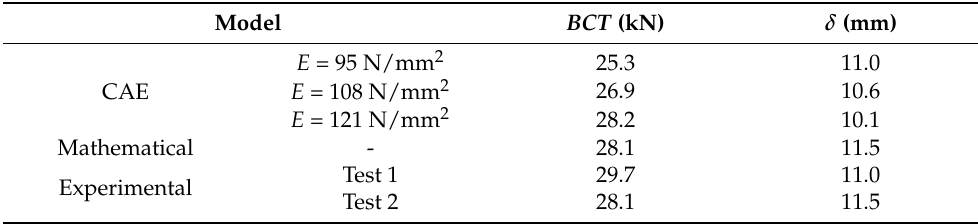
Figure 14. Comparison of force-displacement curves among CAE, mathematical and experimental results for the O-04 item. Table 7. Results of the BCT force and δ vertical displacement for experimental tests and for the CAE and mathematical models of the R-04